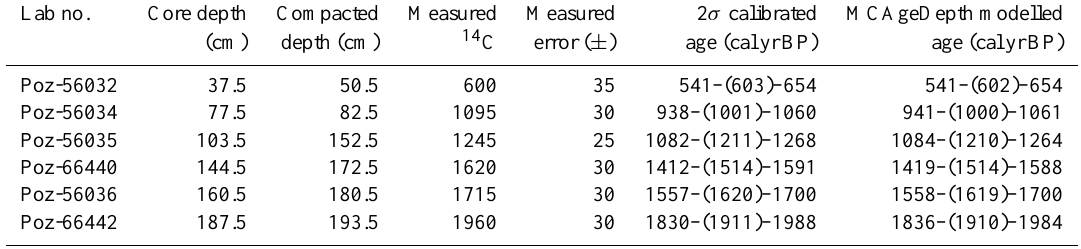
Table 1. Radiocarbon ages of core Tuz 694 of Cerro Tuzgle peatland. The calibrated age ranges were calculated using CALIB 7.0.4 and the IntCal13 data set (Reimer et al., 2013). The modelled ages are the result of a probabilistic age–depth model using MCAgeDepth (Higuera et al., 2009). The range represents the 2 σ values, and the median ages are in parentheses. Lab no.